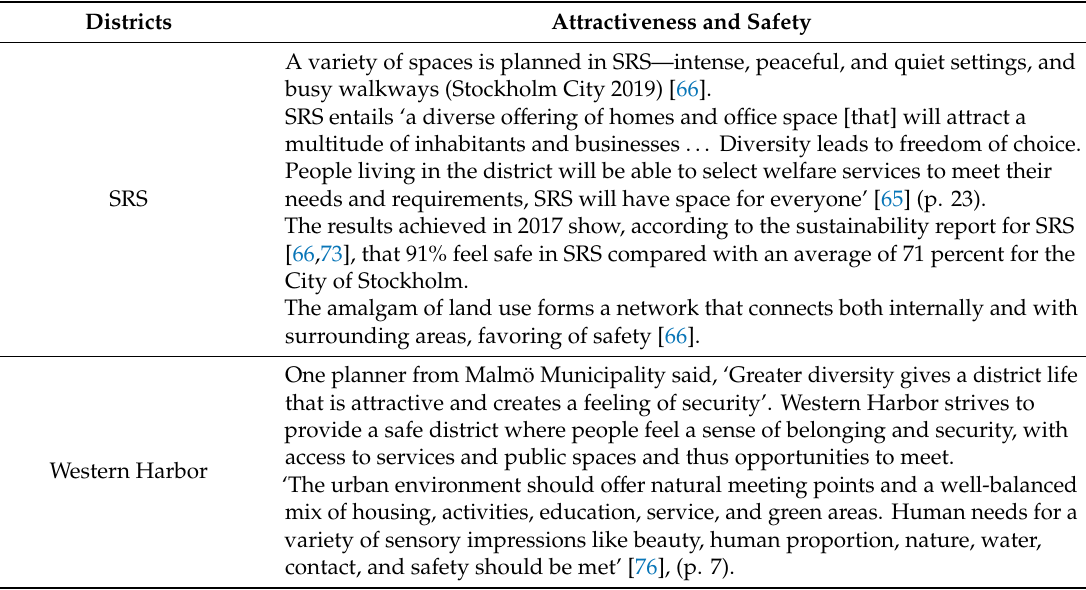
Table 8. Attractiveness and safety in SRS and Western